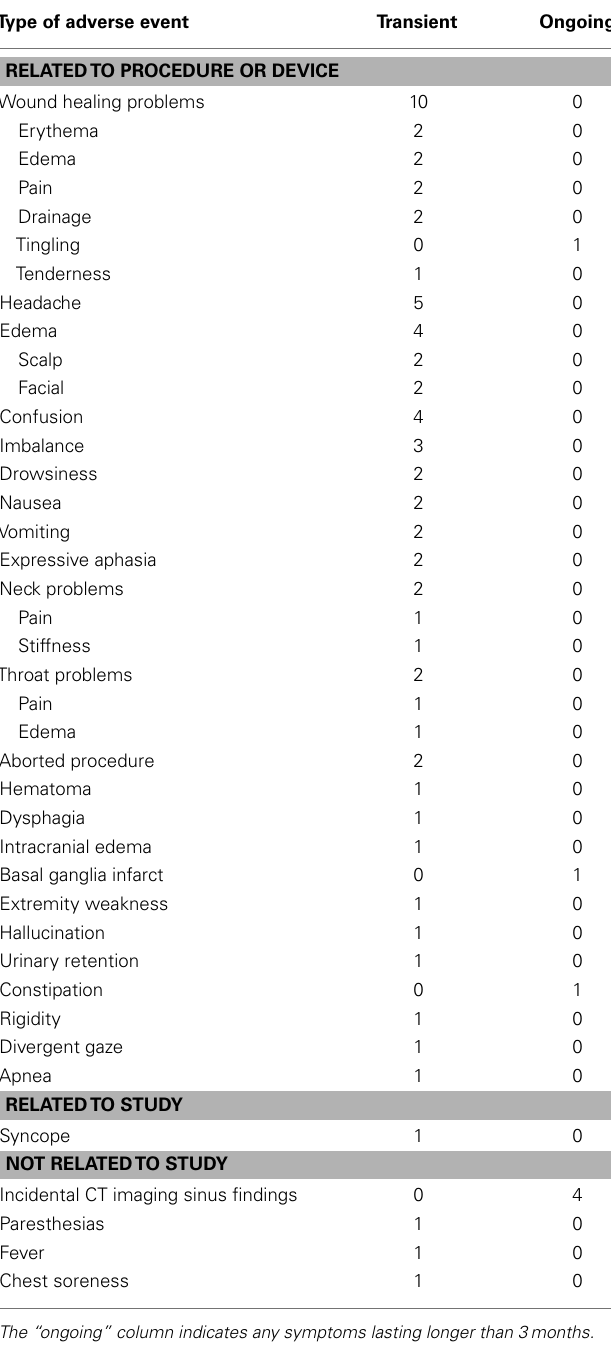
Table 2 | Perioperative adverse events, n = 56 [adapted with permission from Kahn et al.